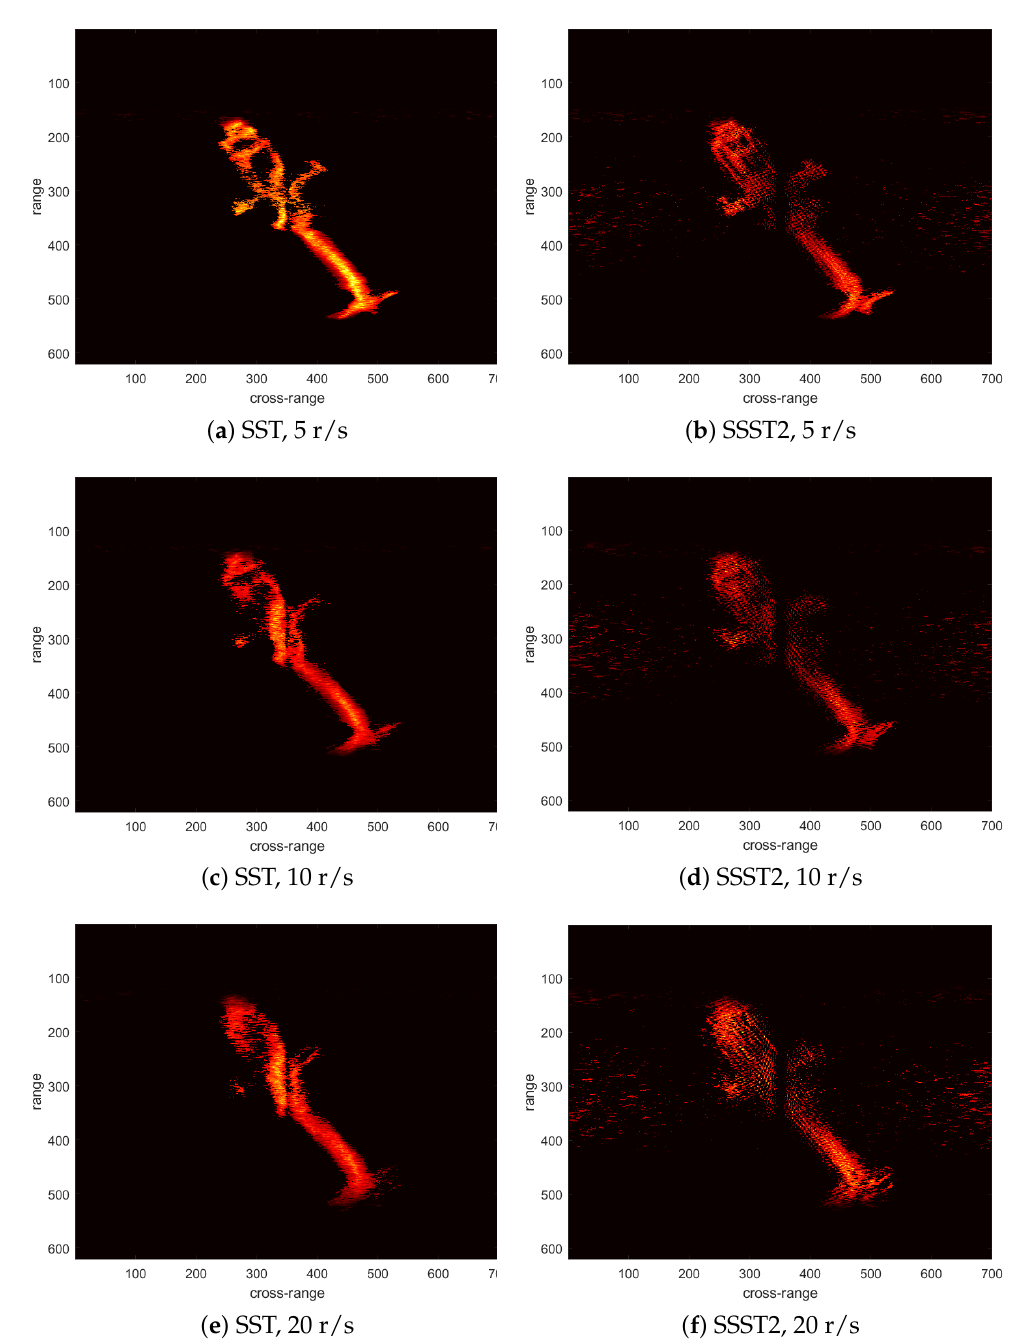
Figure 8. Imaging separation results of simulated